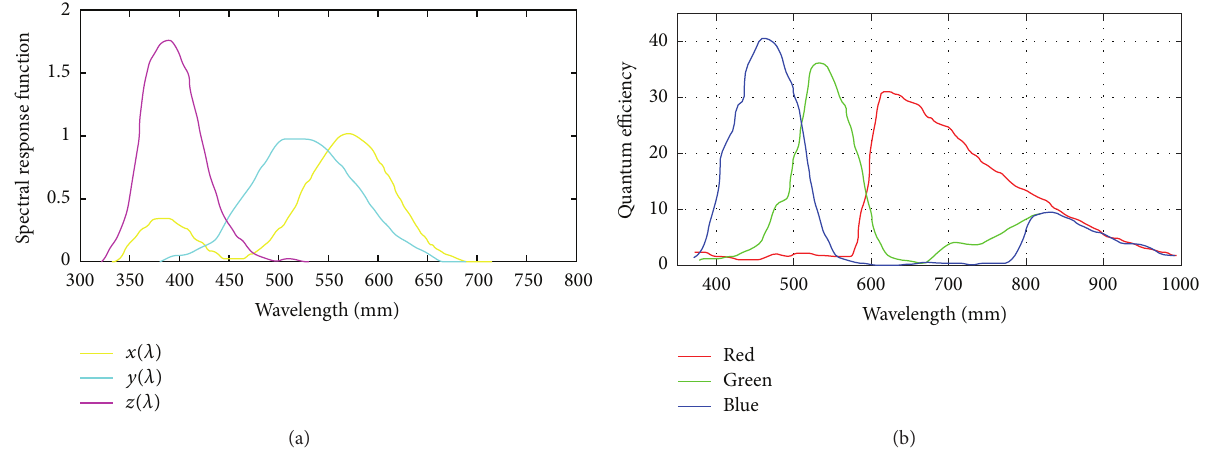
Figure 1: Comparison of spectral response: (a) CIE 2 ∘ color matching functions and (b) spectral response functions of our digital